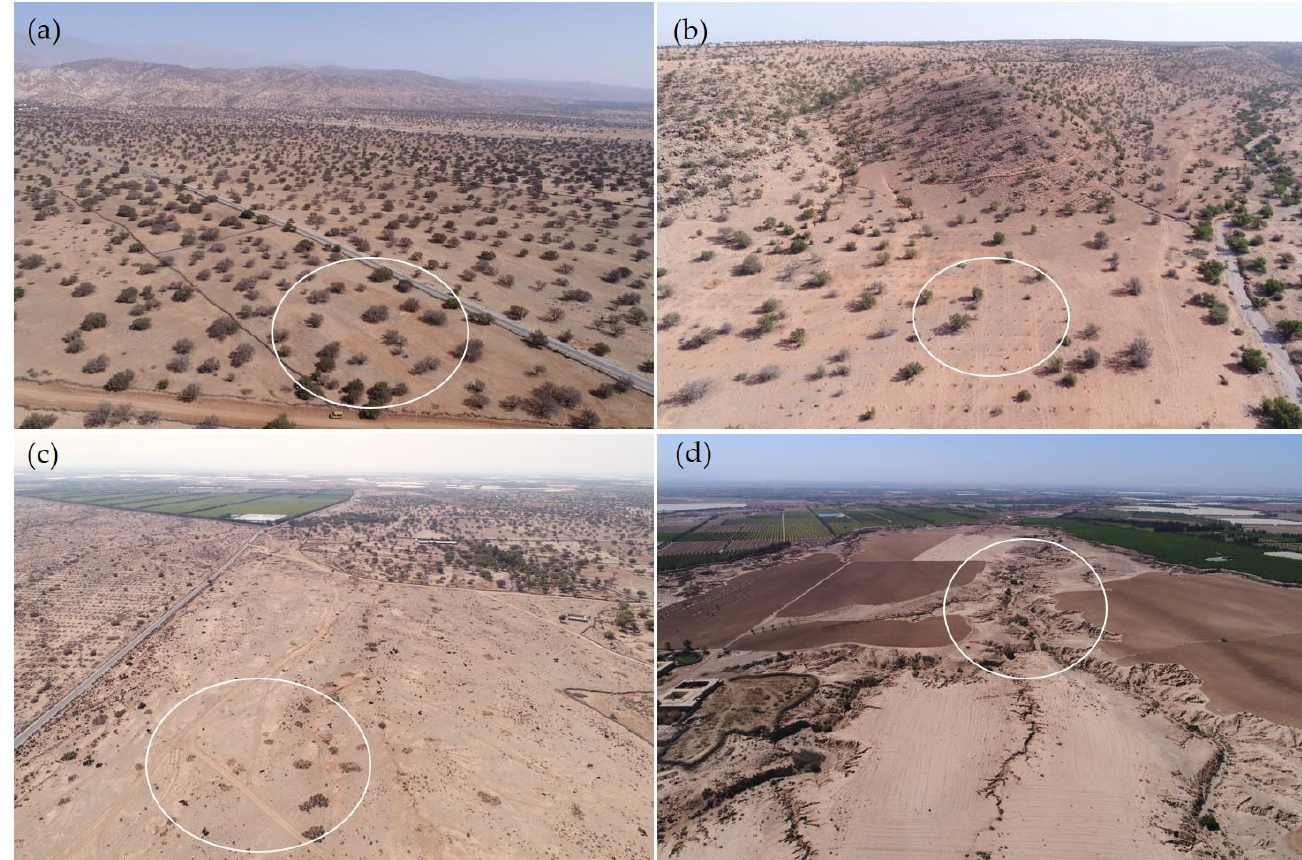
Figure 2. Sites ( a ) argan woodland, ( b ) reforestation area, ( c ) wasteland, ( d ) wadi (with marked test areas) .